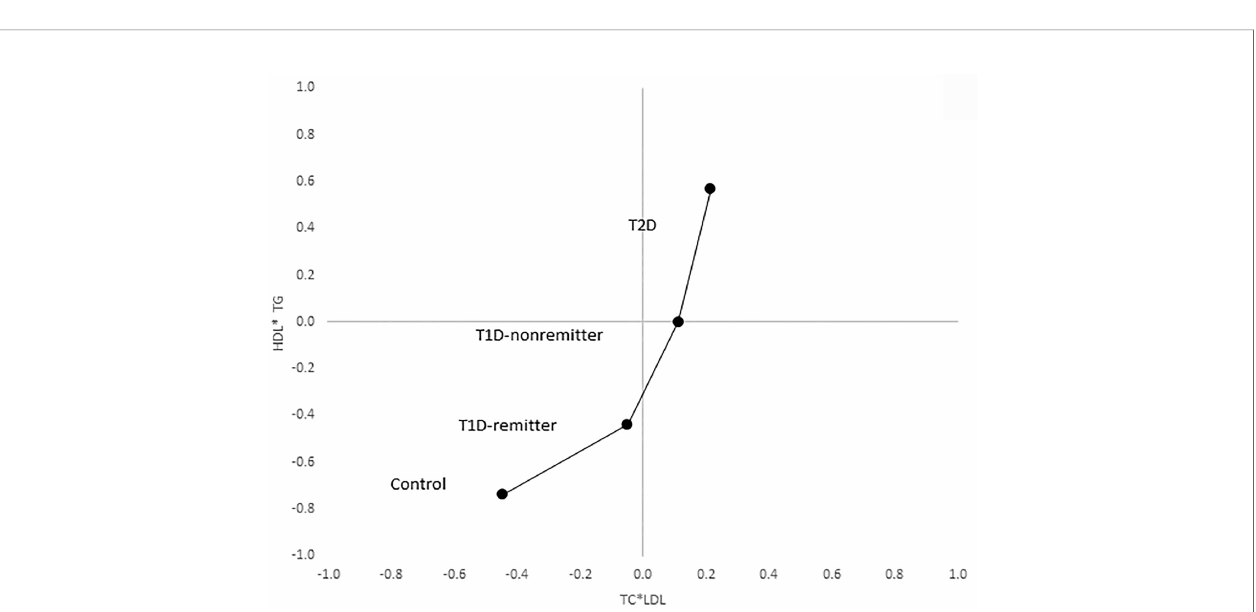
FIGURE 7 | Mean composite score for lipid parameters by factor analysis. Two-dimensional depiction of the mean composite scores of factor 1 (TC*LDL) and factor 2 (HDL*TG) from the factorial analysis of the 7 lipid parameters. Both the controls and remitters are in the low composite risk quadrant, whereas non-remitters and remitters are in the higher risk quadrants. Both factor 1 and factor 2 explained 90% of the variance in the original lipid parameters, p values 0.0042 and <0.0001 respectively. The p-values for linear trends were obtained from linear regression models on composite scores, adjusted for age, sex, ethnicity and BMI.